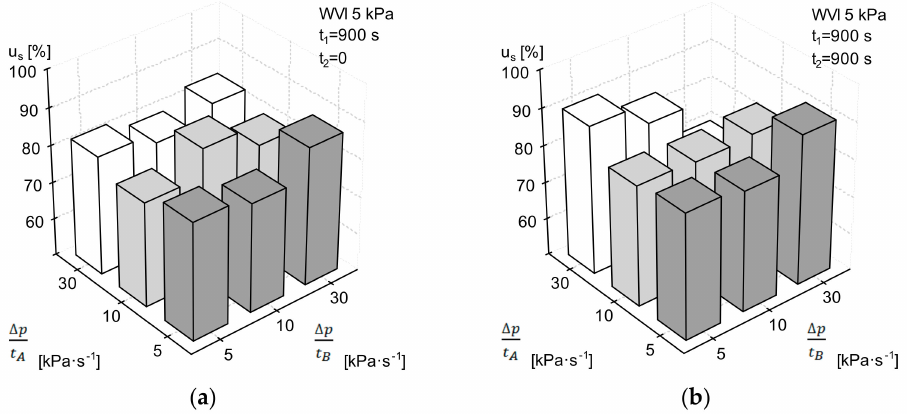
Figure 6. Dependence of the percentage of apple tissue staining u S on the pressure change rate in the WVI cycle, for t 1 = 900 s and di ff erent values of t 2 : ( a ) t 2 = 0 s, ( b ) t 2 = 900